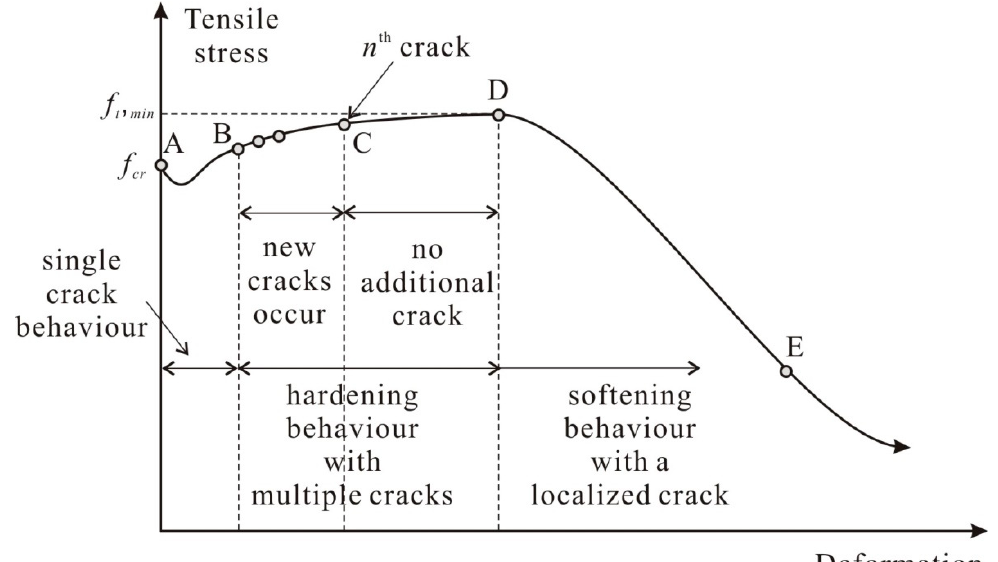
Figure 3. Tensile stress-deformation response in HPFRC.